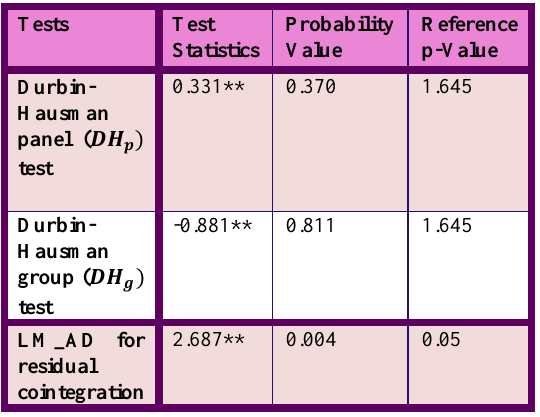
Table 5: Cointegration Test Results for Companies Traded in Other Countries’ Stock